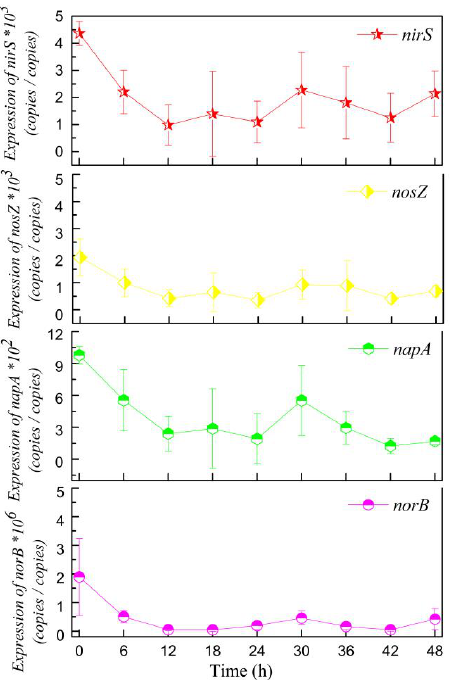
Figure 4. Aerobic denitrifying gene expression of strain RAD-2 during 48 h incubation.